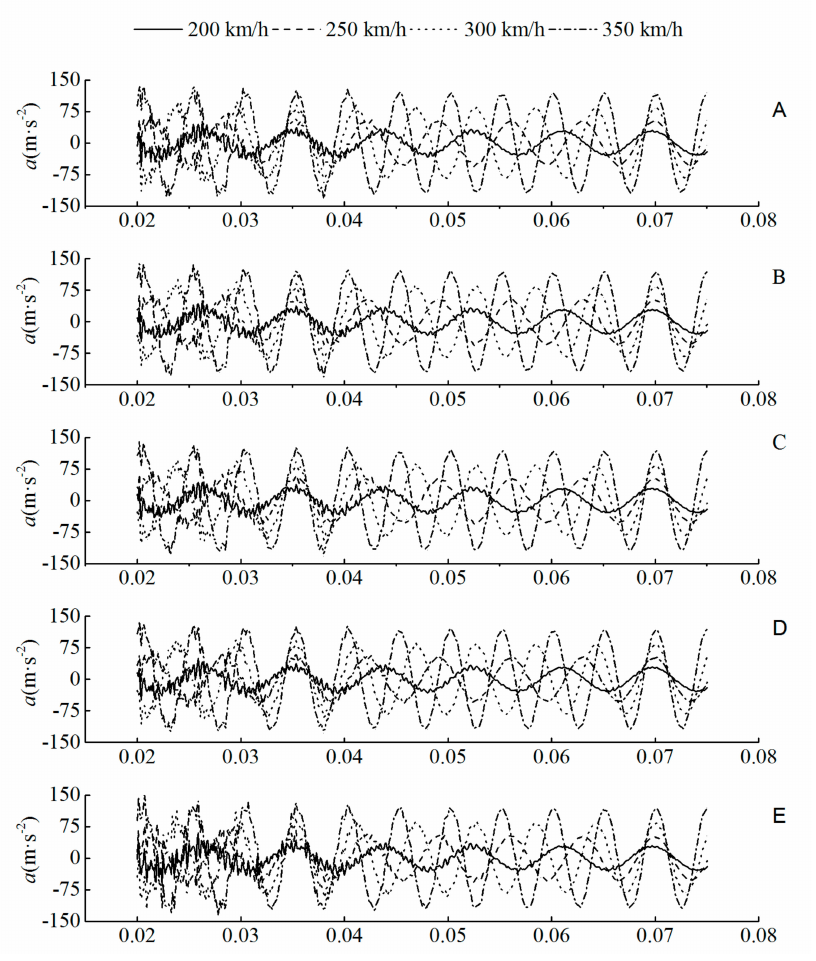
Figure 13. Time histories of vertical vibration acceleration vs. speed at points A to